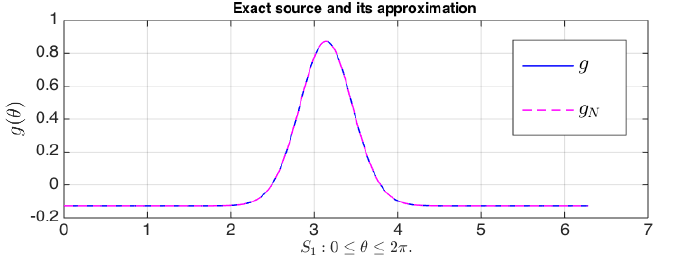
Figure 10. Plots of exact source g (blue) and its approximation g N by its truncated Fourier series (magenta) for N = 30 terms.